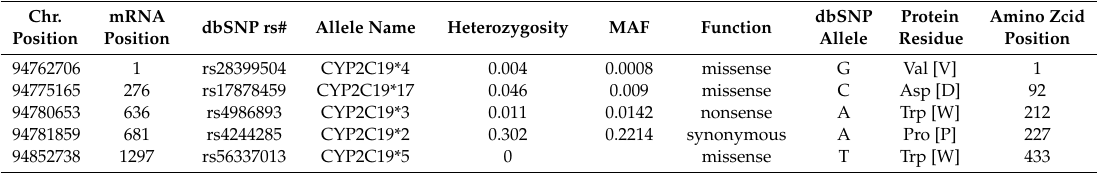
Table 3. List of single nucleotide polymorphisms (SNPs) involved in clinical drug metabolism in children with